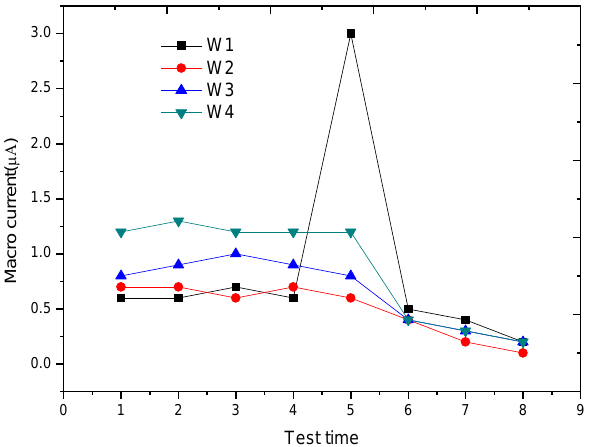
Figure 15. Variation of macro current for each monitoring